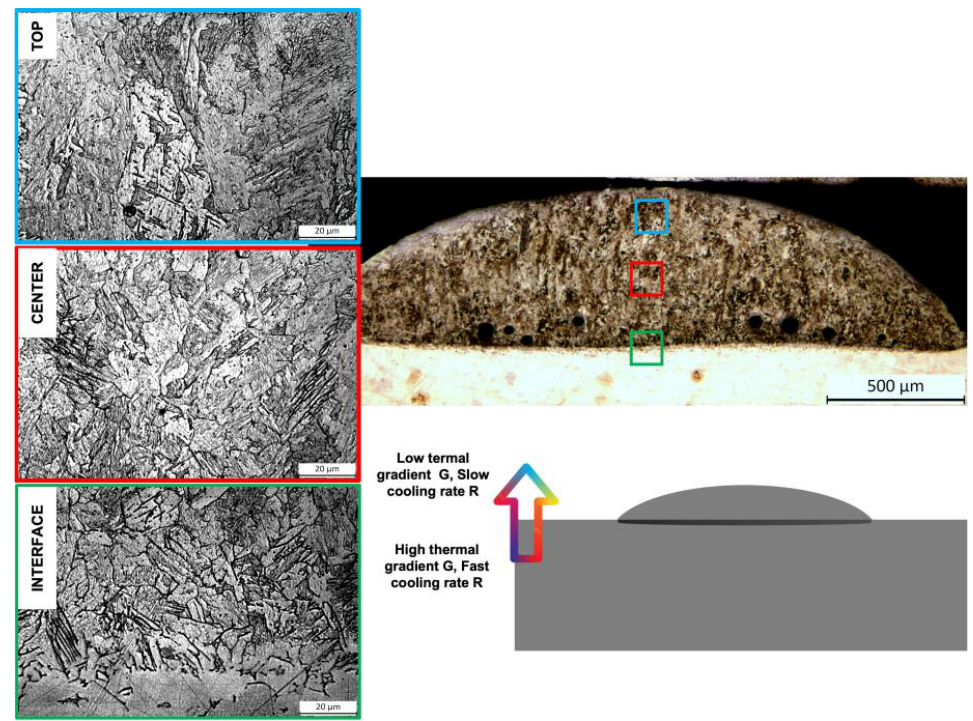
Figure 8. Evolution of microstructure from the clad/substrate interface up to the top of the clad in sample S4_A_2.